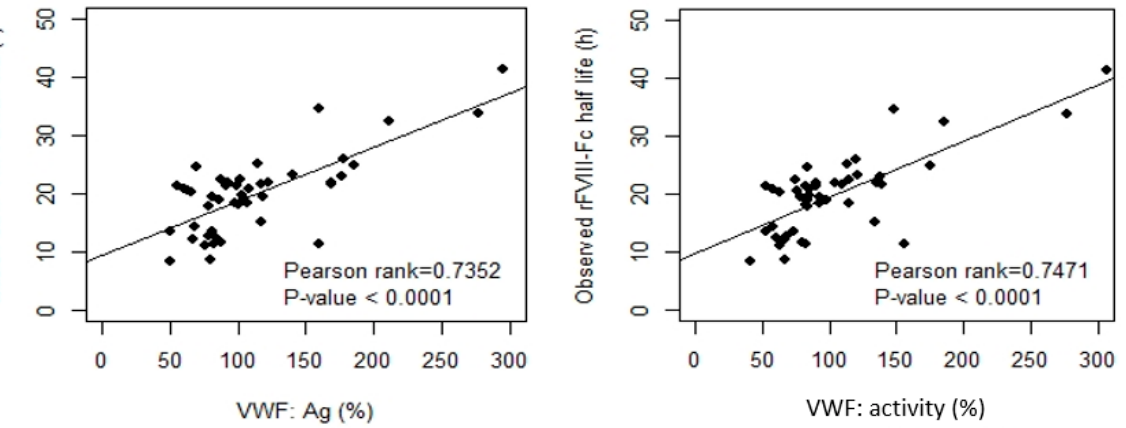
Figure 2. Clinical variables, including body weight (BW), body mass index (BMI), baseline VWF:Ag, and baseline VWF:activity, related to the observed rFVIII-Fc half life in the development cohort (n = 46). Both BW and BMI had a weak or moderate positive correlation to half life ( p -value < 0.01). Both baseline VWF:Ag and baseline VWF:activity had a strong positive correlation to half life ( p -value < 0.0001). The drawn lines show the best fit by univariate linear